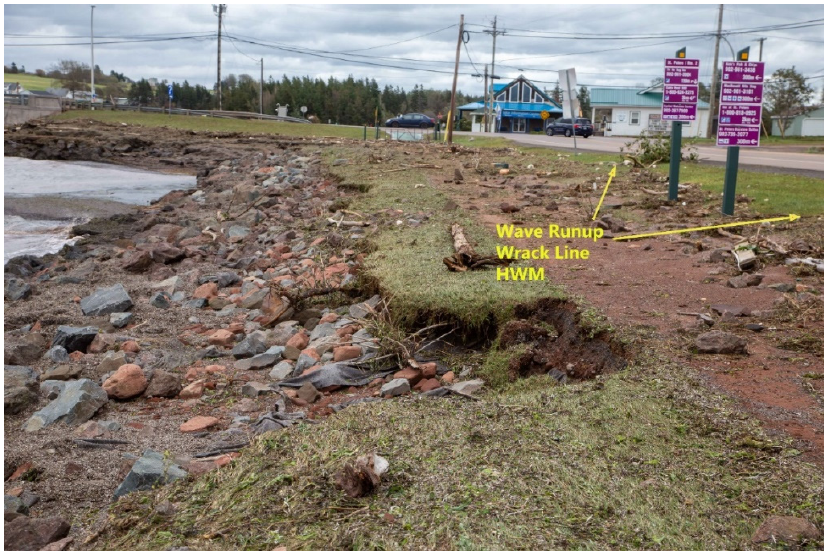
Figure A1. HWM from Wave Runup Wrack Line at St Peters